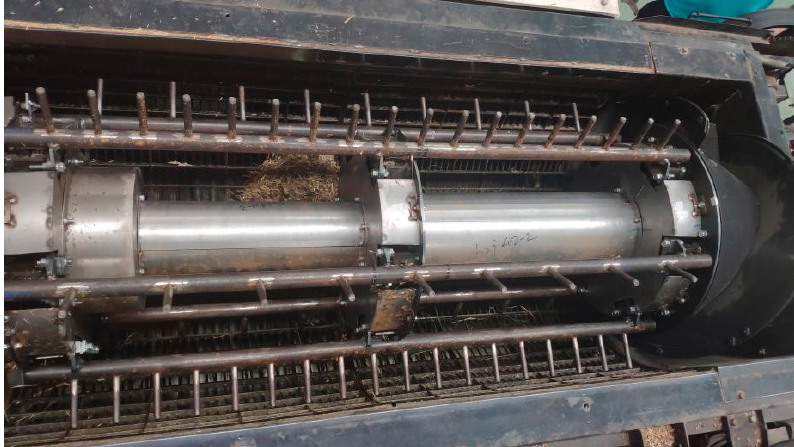
Figure 5. Threshing device for individually adjusting threshing rod elongation.